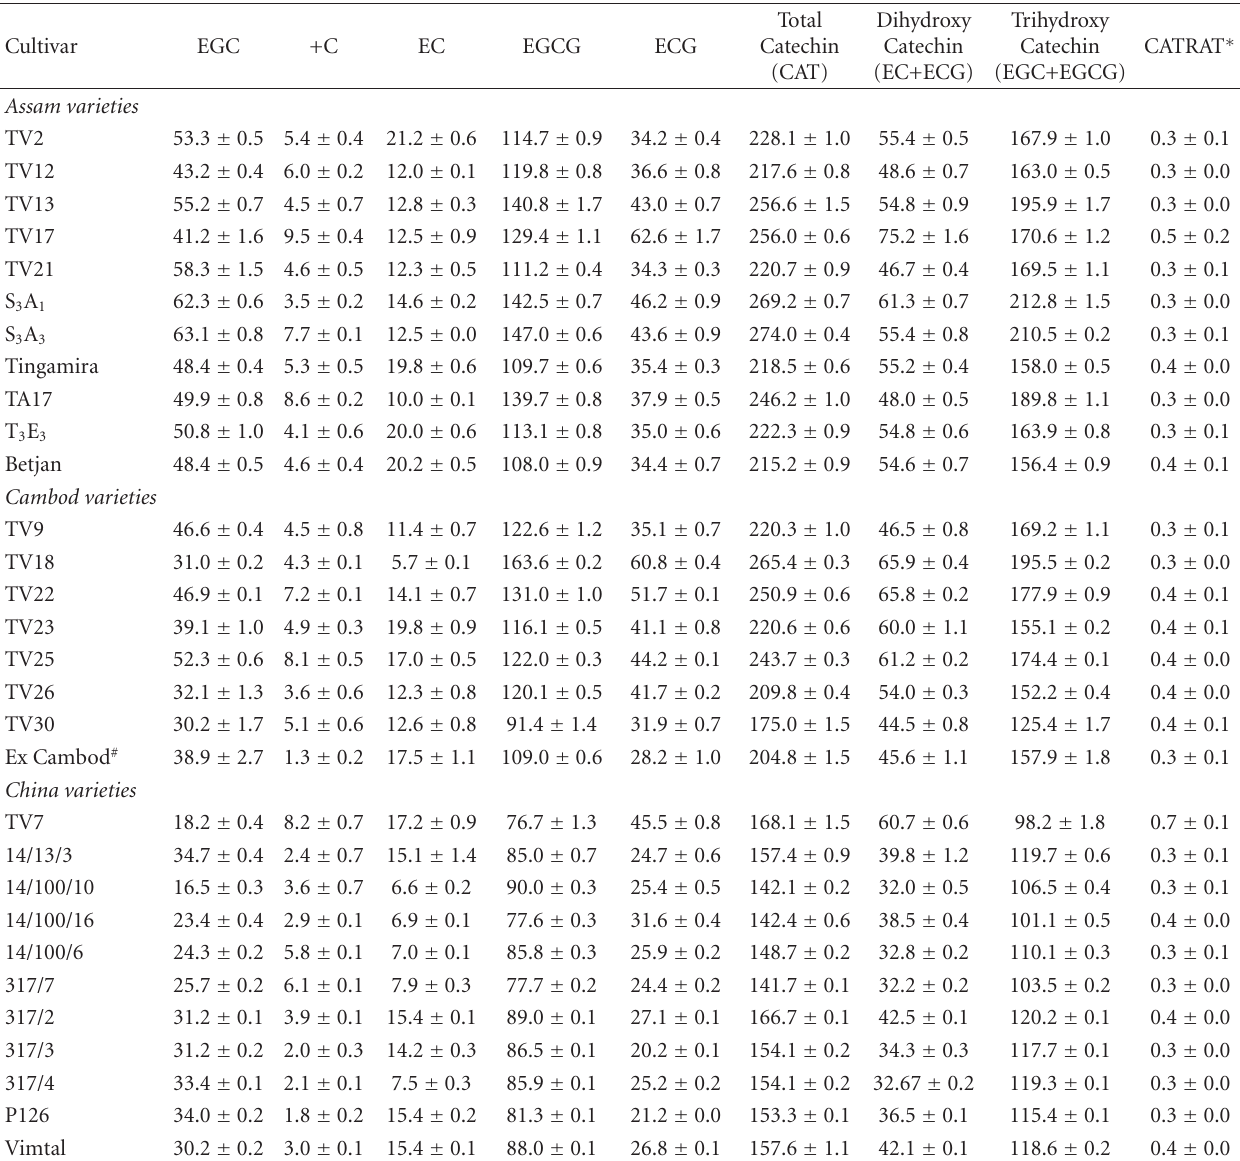
Table 1: Catechin profile of di ff erent green tea leaves (all units are in mg g − 1 except catechin ratio, data represent the mean of three replicates ± standard